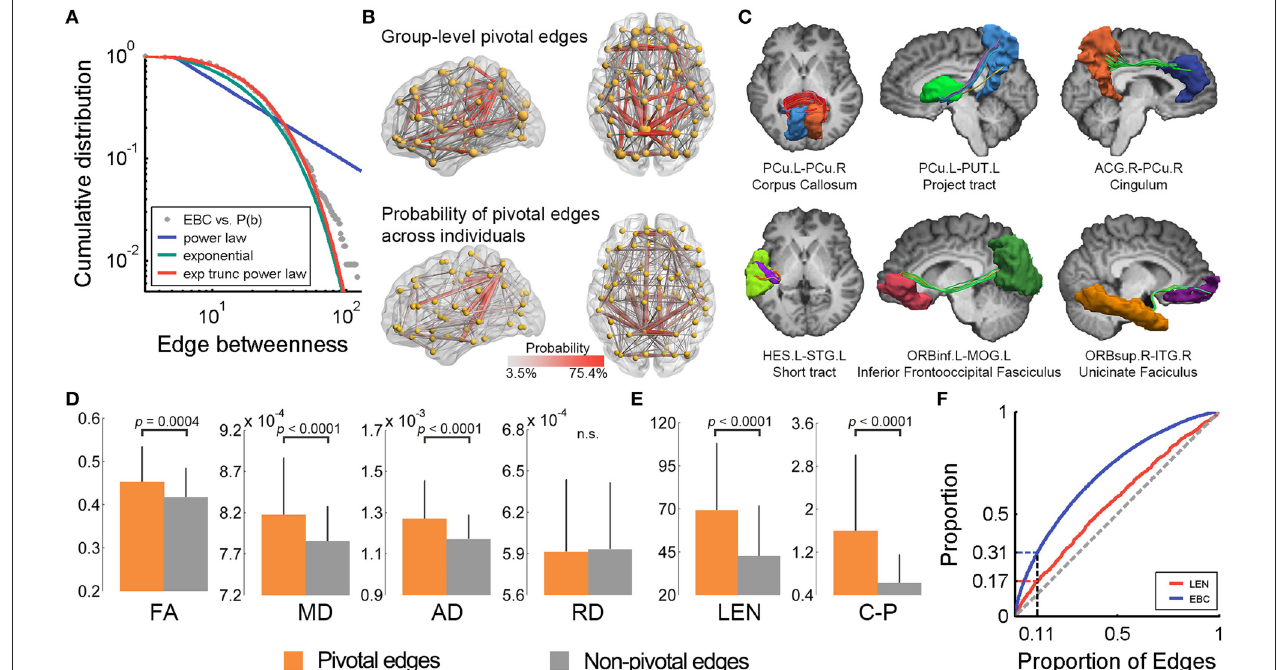
FIGURE 2 | The pivotal edges and their wiring substrates in the human WM network. (A) The EBC distribution of the WM network was best fitted by an exponentially truncated power-law form. (B) The spatial pattern of the pivotal edges (red) of the group-level WM network (upper) is quite similar to the probability map of the pivotal edges across individuals. (C) Several pivotal WM edges were manifest in one representative subject. (D) The pivotal edges showed significantly higher levels of WM microstructural organization, as indicated by FA, MD, and AD, but not RD, than the non-pivotal ones. The error bars represent the standard deviation. (E) The pivotal edges also had greater streamline length and better cost-performance than the non-pivotal ones. (F) The curves for the proportion of edges vs. proportions of EBC and streamline length. EBC, edge betweenness centrality; exp, exponential; trunc, truncated; PCu, precuneus; PUT, putamen; ACG, anterior cingulate and paracingulate gyri; HES, Heschl’s gyrus; STG, superior temporal gyrus; ORBinf, inferior frontal gyrus, orbital part; MOG, middle occipital gyrus; ORBsup, superior frontal gyrus, orbital part; ITG, inferior temporal gyrus; FA, fractional anisotropy; MD, mean diffusivity; AD, axial diffusivity; RD, radial diffusivity; LEN, streamline length; C-P, cost-performance; n.s., not significant; L, left; R,